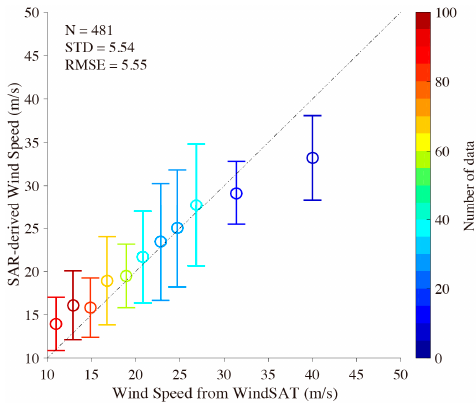
Figure 9. Comparison between SAR-derived wind speeds and measurements from Windsat grid winds between 10 m/s and 40 m/s for a 2 m/s bin, in which error bar represents the standard deviation (STD) of wind speed at each bin.